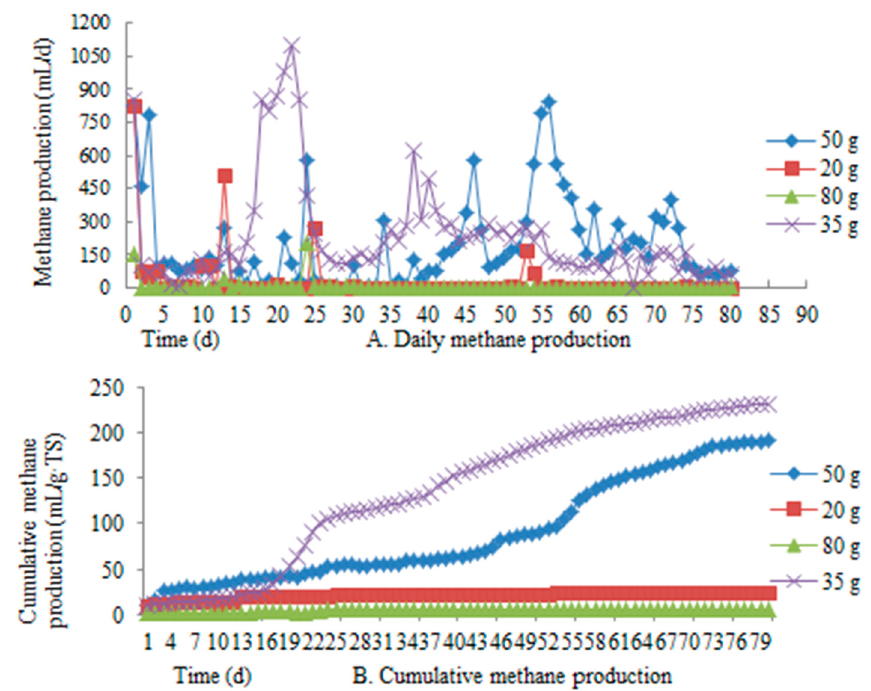
Figure 6. The change in methane production with different dosages of the mushroom residue.